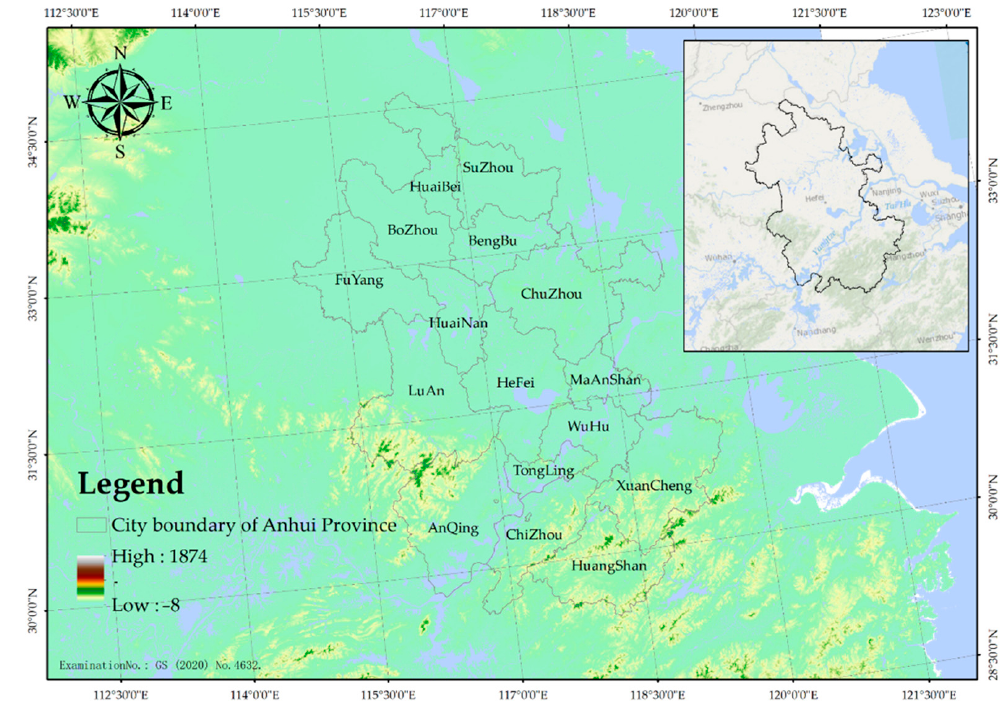
Figure 1. Location of Anhui Province.